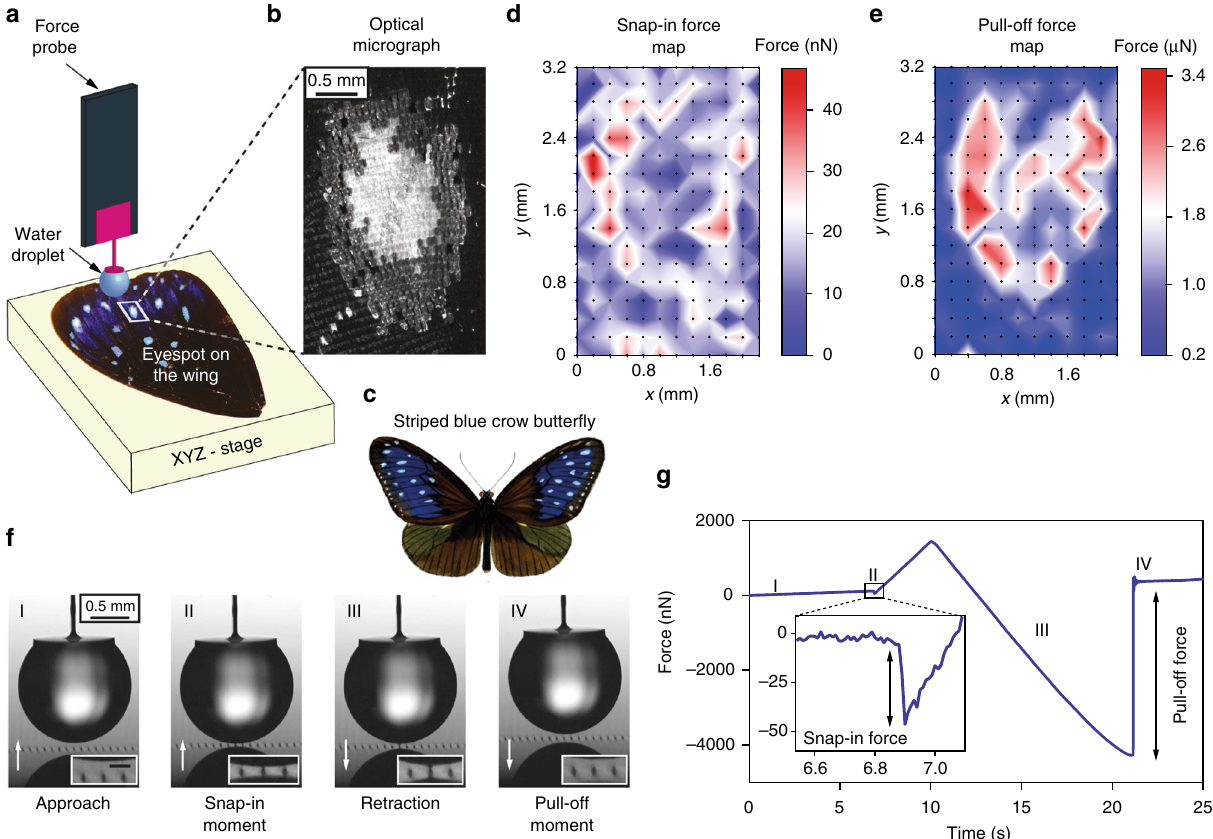
Fig. 1 Concept of scanning droplet adhesion microscopy to construct wetting maps. a Schematic diagram of the microscope (not to scale). b Optical micrograph of scanned eyespot area on the wing of c , striped blue crow butter fl y (typical wing span of adult specimen 80 – 90 mm; image by Frederic Moore, PD-1923); with corresponding d snap-in and e pull-off force maps. Dots on d , e denote the measurement points with 200 µ m spacing. Colours in the maps denote measured force values, linearly interpolated between the data points. f Snapshots of individual measurement on a single hydrophobic 5 µ m radius pillar (white arrows indicate direction of sample surface movement, inset scale bar 70 µ m), and g corresponding typical force curve. Roman numerals in f , g indicate corresponding moments in the